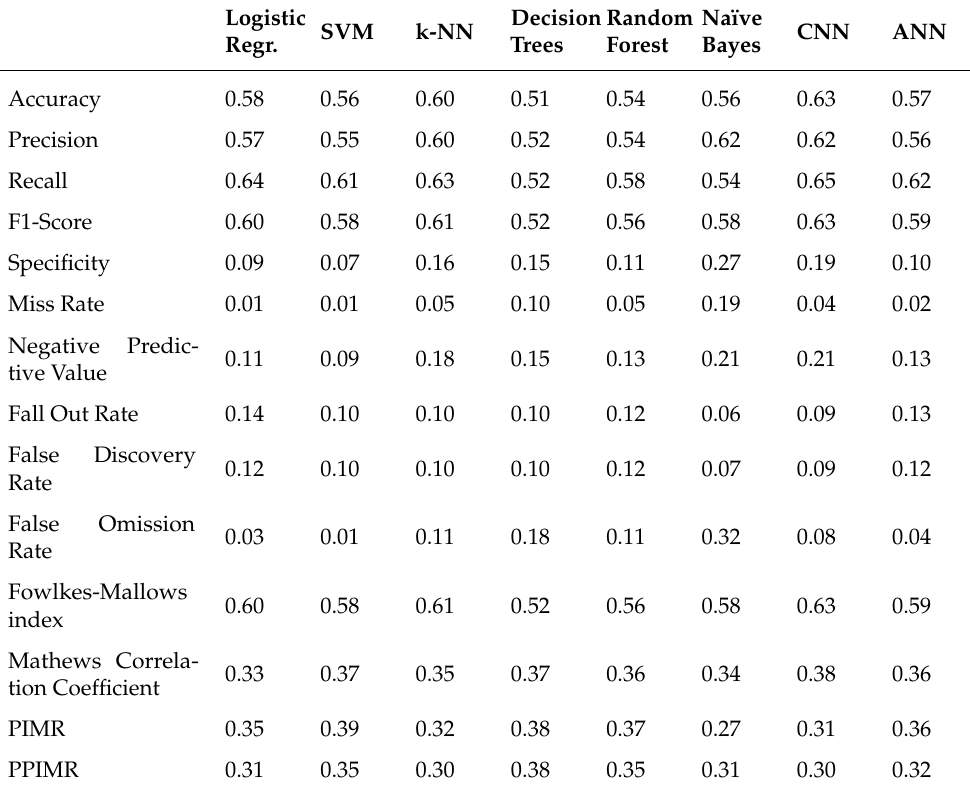
Table 8. The performance metrics of the “2 × 2 + IM ” reduced confusion matrix for each one of the applied